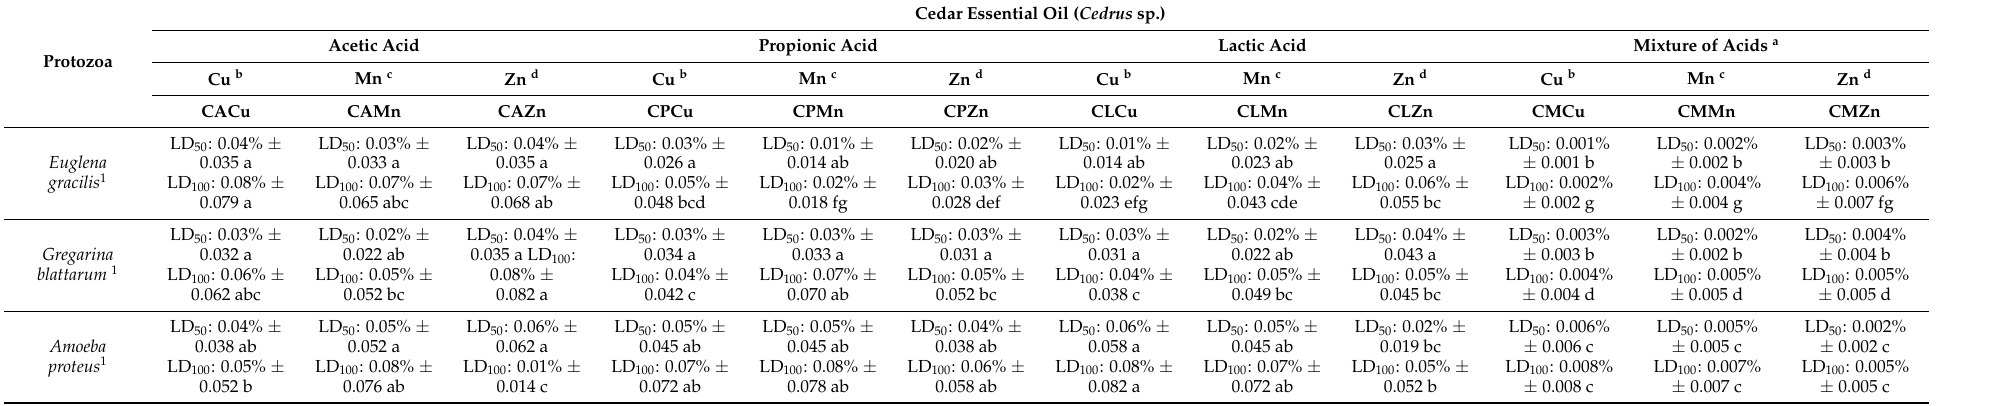
Table 7. LD 50 , LD 100 values of cedar essential oil ( Cedrus sp .) (C), organic acids (Acetic acid—A, Propionic acid—P, Lactic acid—L, Mixture of acids—M) and metal ion against selected